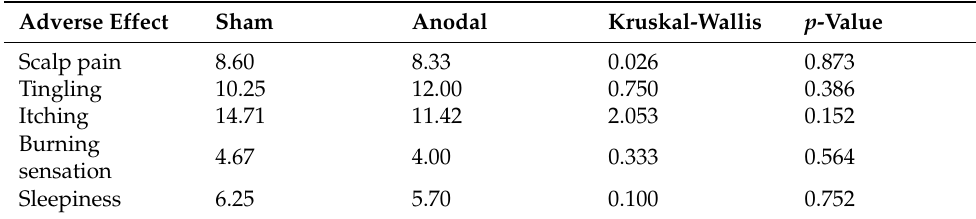
Table 2. Adverse effects of tDCS. Data are rank mean.